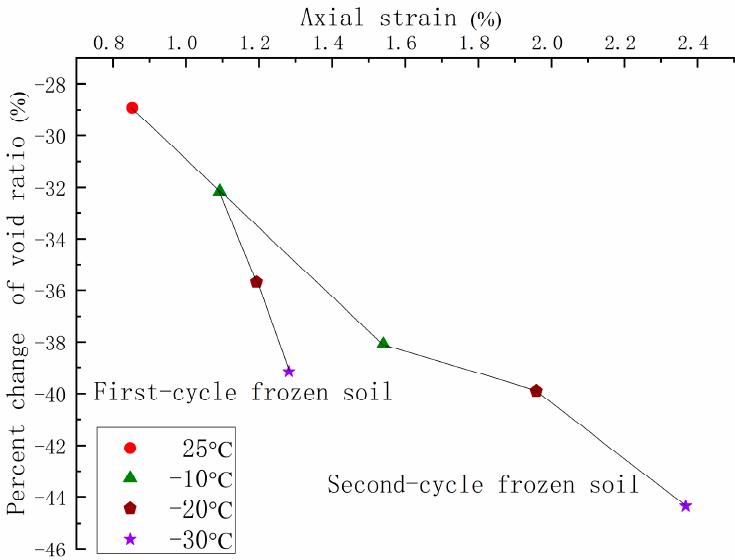
Figure 21. Percentage change of the void ratio vs. axial strain curve.